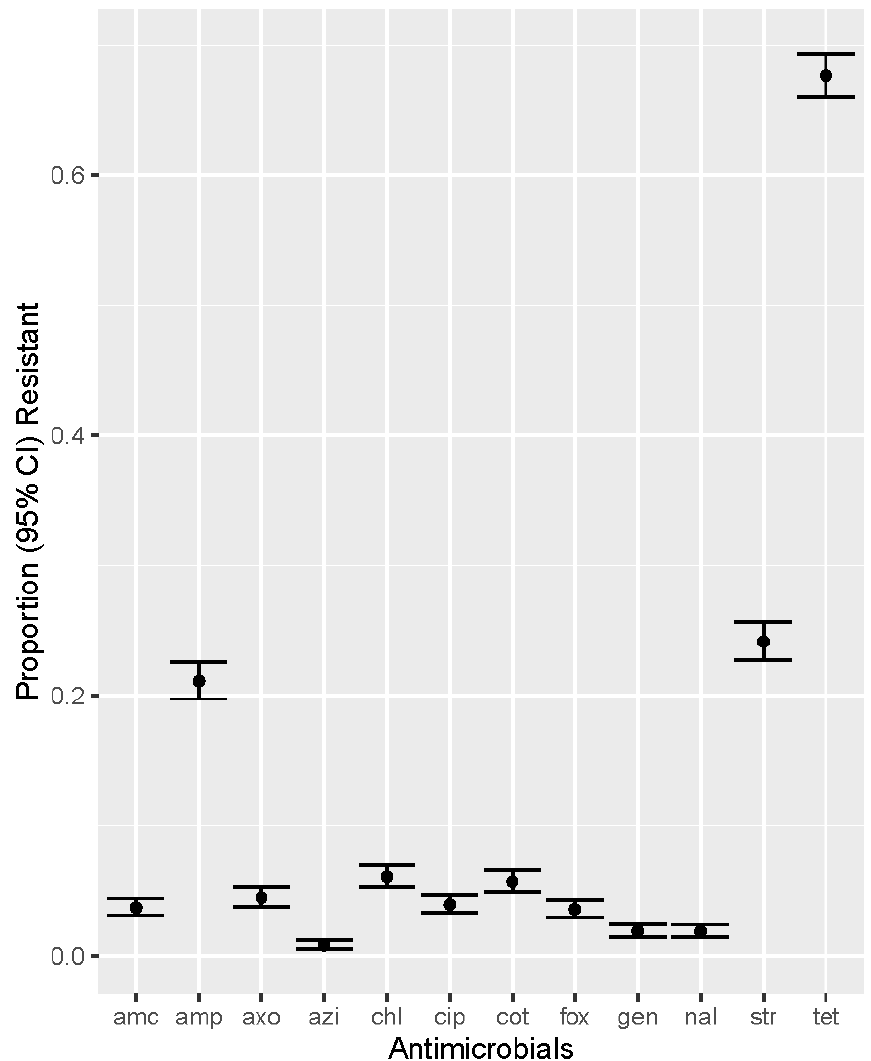
Figure 1. Prevalence of resistance to twelve antimicrobials in commensal Escherichia coli (n = 3237) isolated from swine at slaughter across the US, 2013–2019. AMC ‒ Amoxicillin-Clavulanic acid;